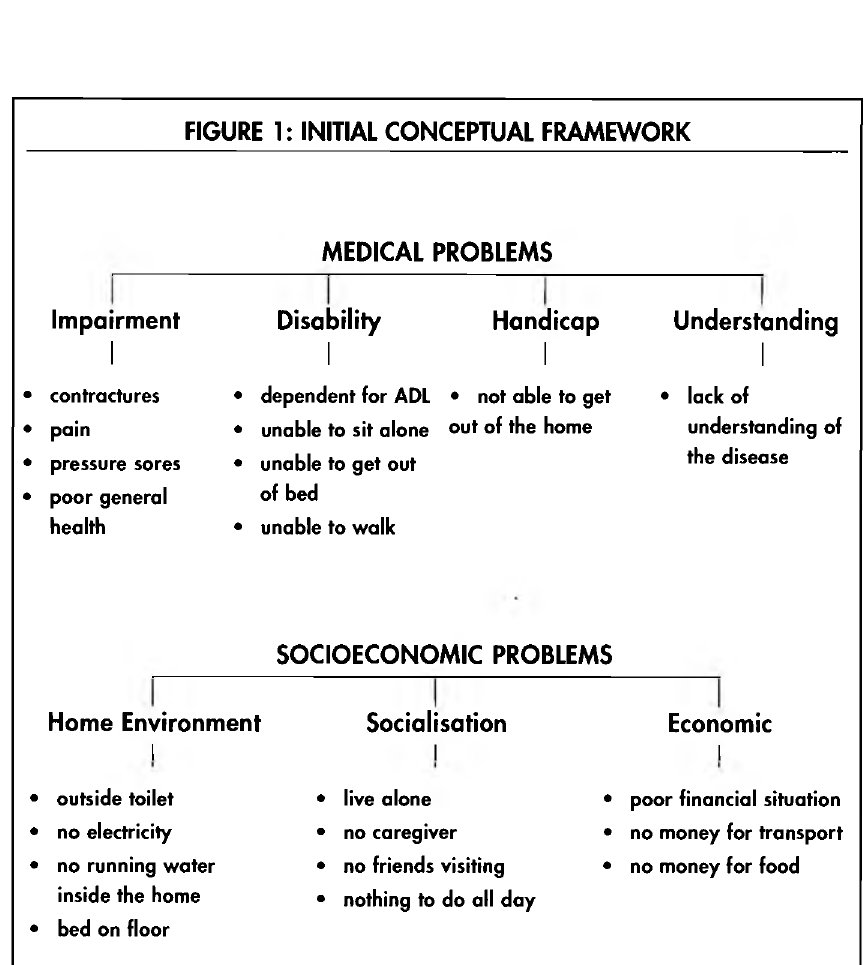
FIGURE 1: INITIAL CONCEPTUAL